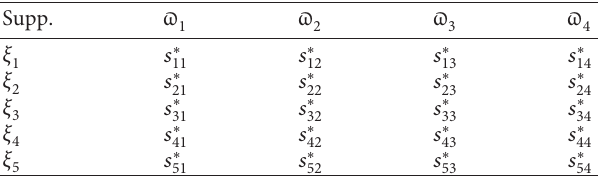
Table 31: Pessimistic aggregated weighted picture hesitant fuzzy decision matrix.